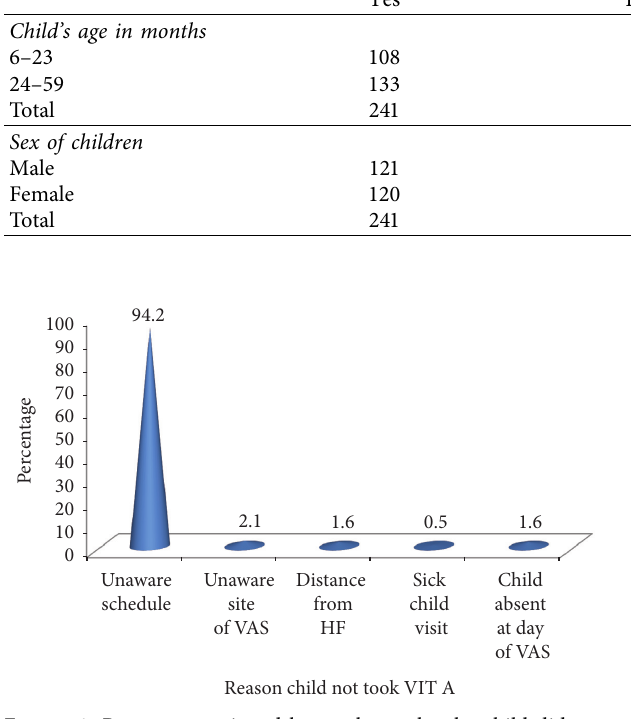
Table 6: Vitamin A coverage in the last six months among children aged 6–59 months in Aleta Chuko woreda, 2019. Characteristics